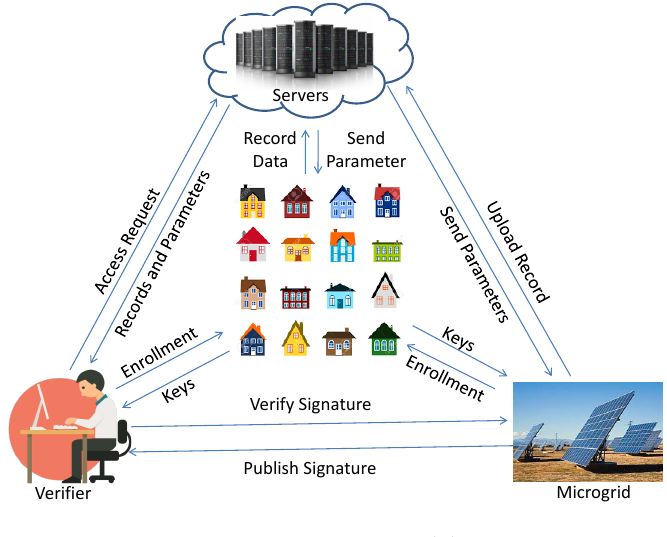
Figure 2. System